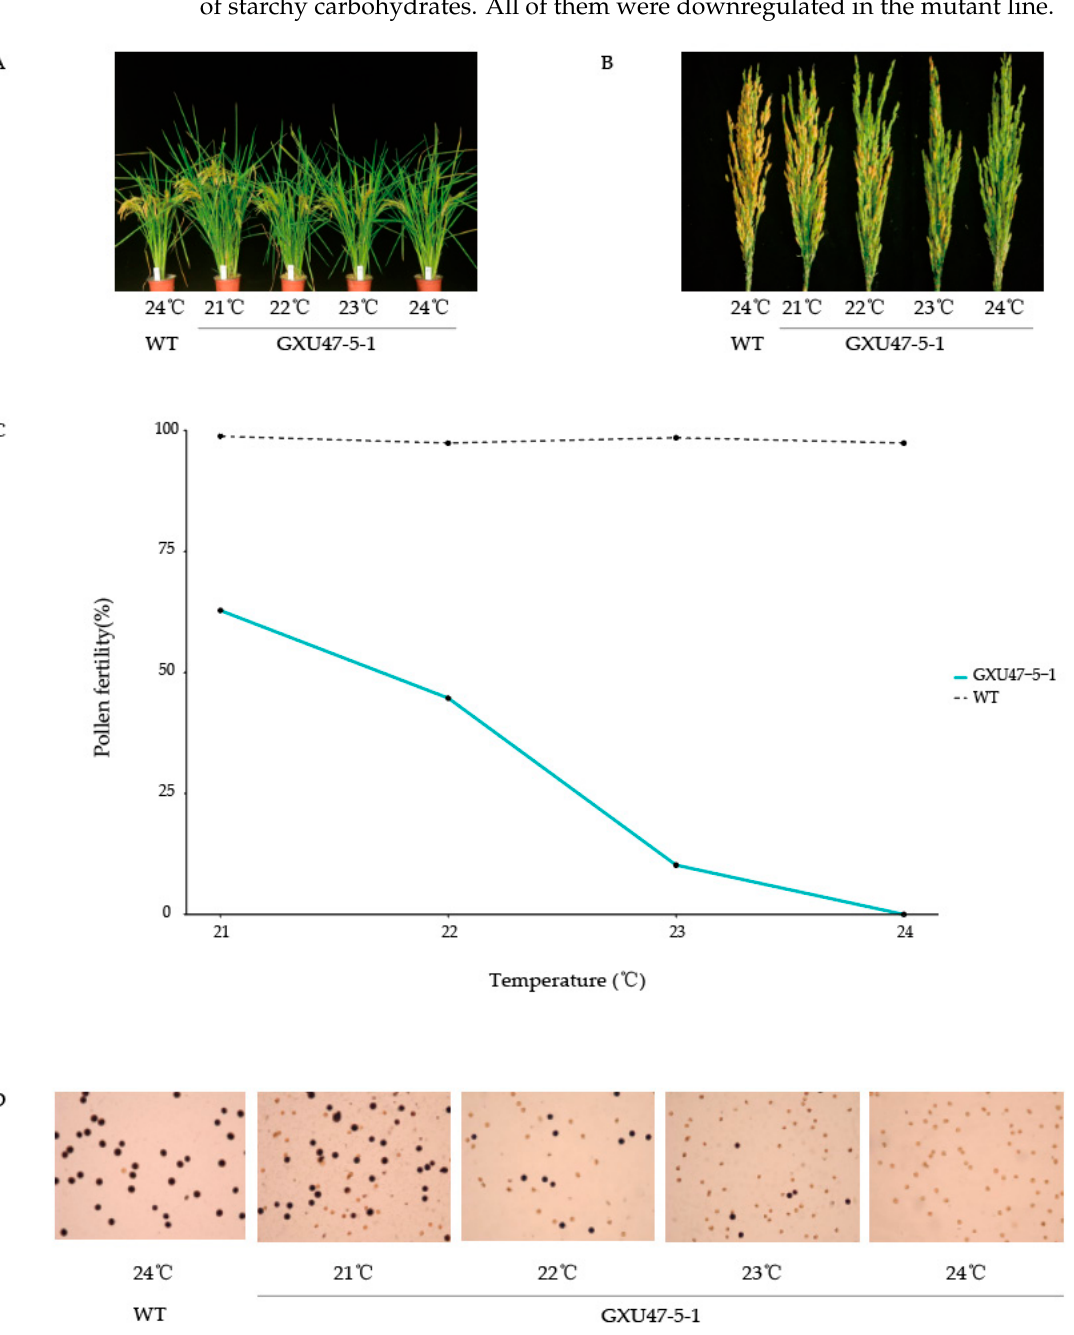
Figure 2. Male fertility transformation of line GXU47-5-1. ( A ) Plant morphologies of WT and GXU47-5-1 at different temperatures. ( B ) Change in spikelet fertilities in panicles of WT and GXU47-5-1 along with changes in temperature. ( C ) Trend of pollen fertility rates with changes in temperatures. ( D ) Observation of pollen fertility rates of WT and GXU47-5-1 at different temperatures under a microscope.